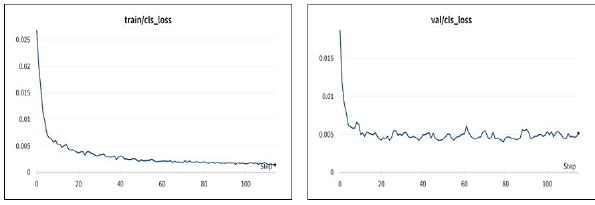
Figure 6: Training loss and validation loss for the class in YOLO v5